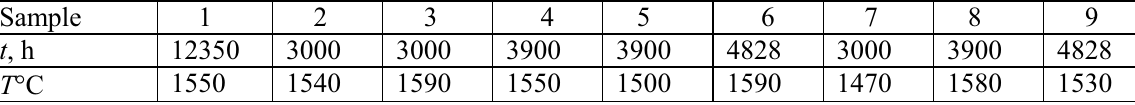
Table 1. Sample irradiation times and